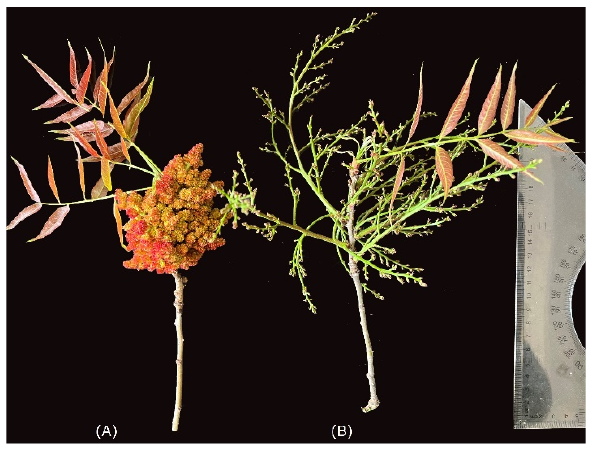
Figure 1. Male ( A ) and female ( B ) inflorescences of P. chinensis.